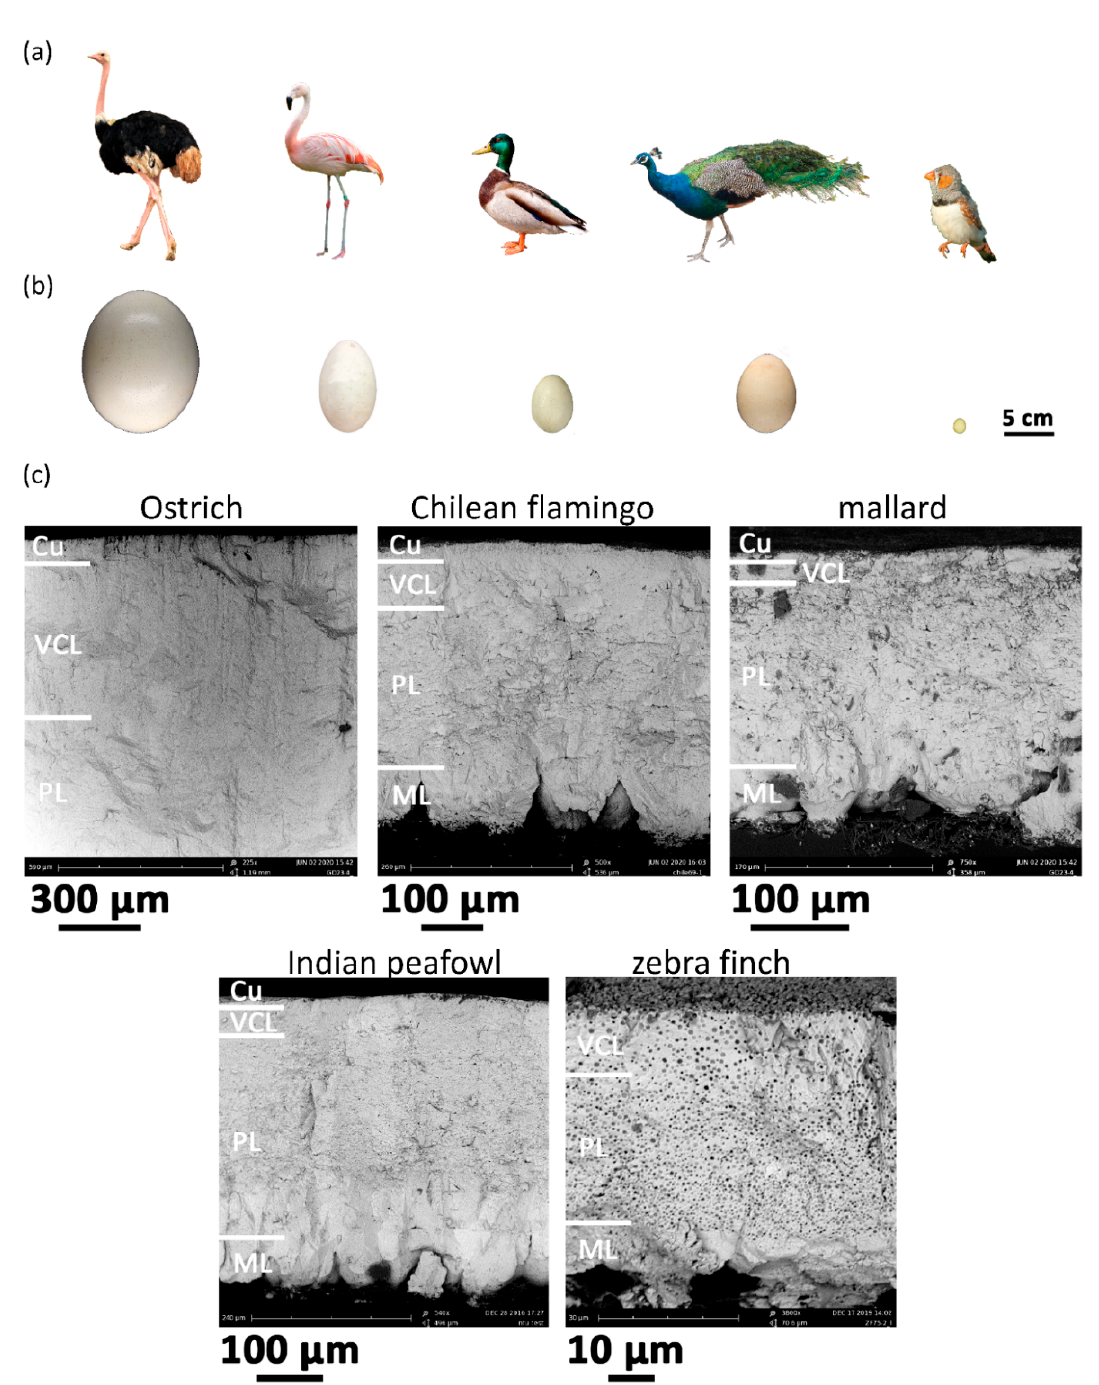
Figure 1. ( a ) Birds, ( b ) eggs, and ( c ) eggshell SEM images of five species. (SEM image for ostrich only contains the upper part of the shell.) Species from left to right: ostrich, Chilean flamingo, mallard, Indian peafowl, zebra finch. Abbreviations: Cu—cuticle, VCL—vertical crystal layer, PL—palisade layer, ML—mammillary layer. The copyright of avian and egg sketch images refers to Tables S2 and